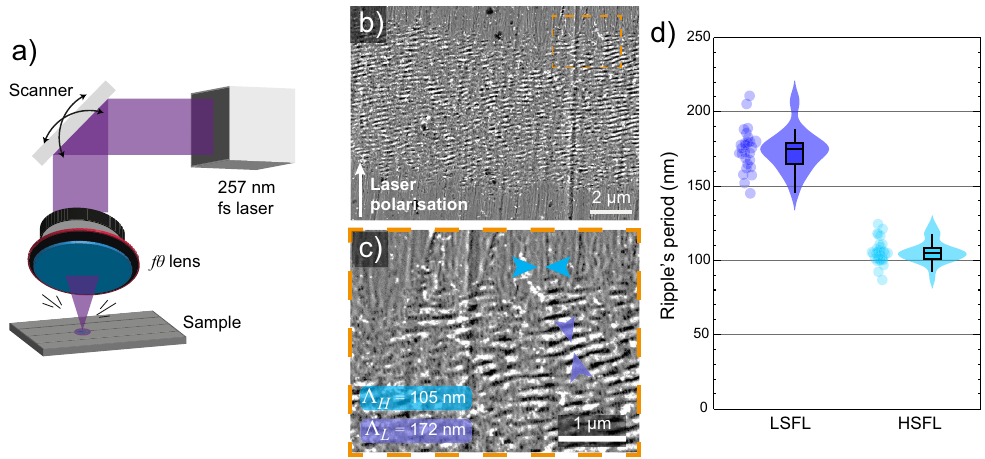
Figure 1. SEM images of generated LIPSS with a 257 nm UV fs-laser. The zoomed image reveals a periodicity ( (cid:31) ) arround 105 and 172 nm respectively for HSFLs and LSFLs. ( a ) Femtosecond laser setup for LIPSS formation, ( b ) SEM observed area with a 11,000 × magnification, ( c ) 30,000 × magnification for HSFL and LSFL visualization, ( d ) Measured distribution of the LSFL and HSFL period (cid:31) L = 172 nm, σ L = 14 nm, (cid:31) H = 105 nm, σ H = 5 nm.